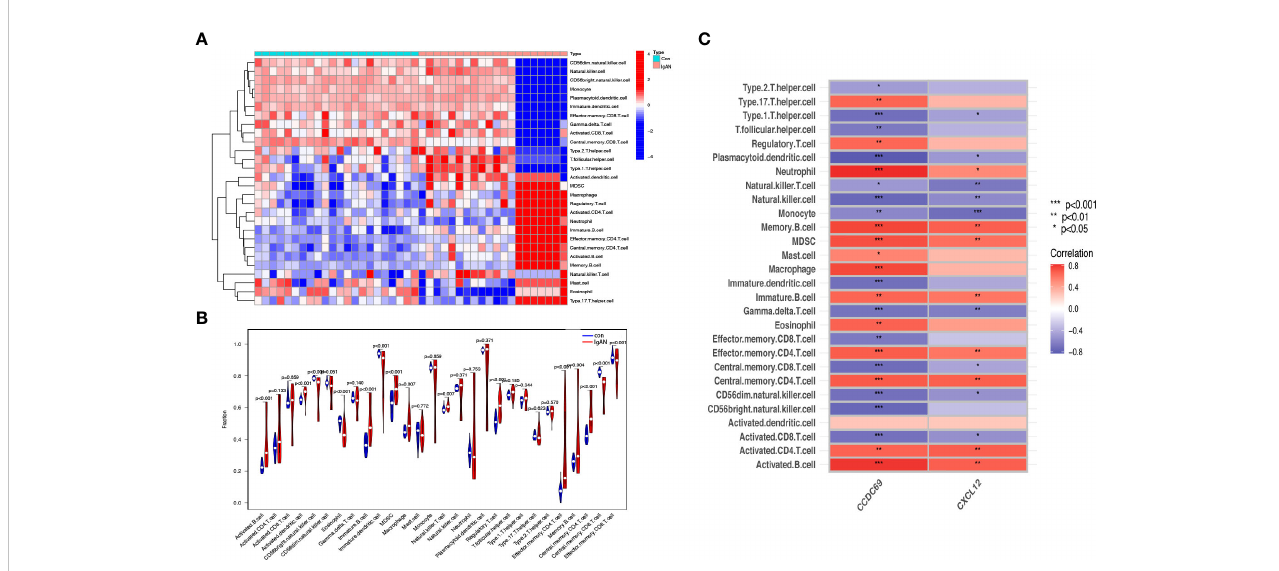
FIGURE 8 Analysis of immune in fi ltration associated with IgAN. Heat (A) and violin plot (B) showing the distribution of 28 immune cells in the GSE93798 sample. (C) The relationship between diagnostic genes and immune cell in fi ltration. Con, control; IgAN, IgA